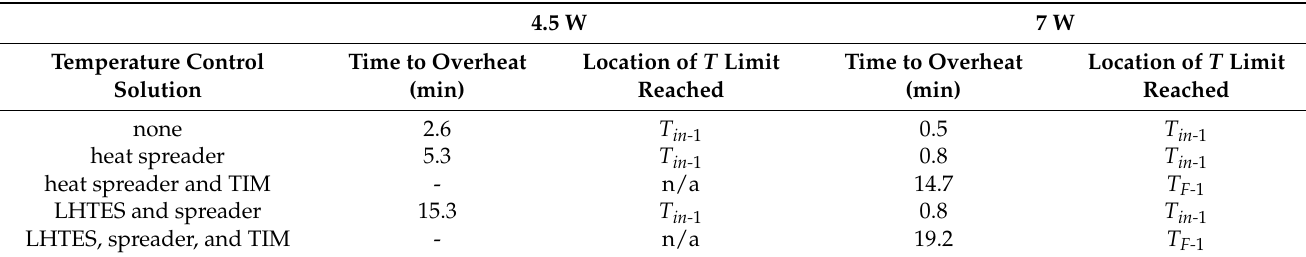
Table 4. Summary of time required for the mock tablet to reach the respective temperature limits with a heat generation rate of 4.5 and 7 W. 4.5 W 7